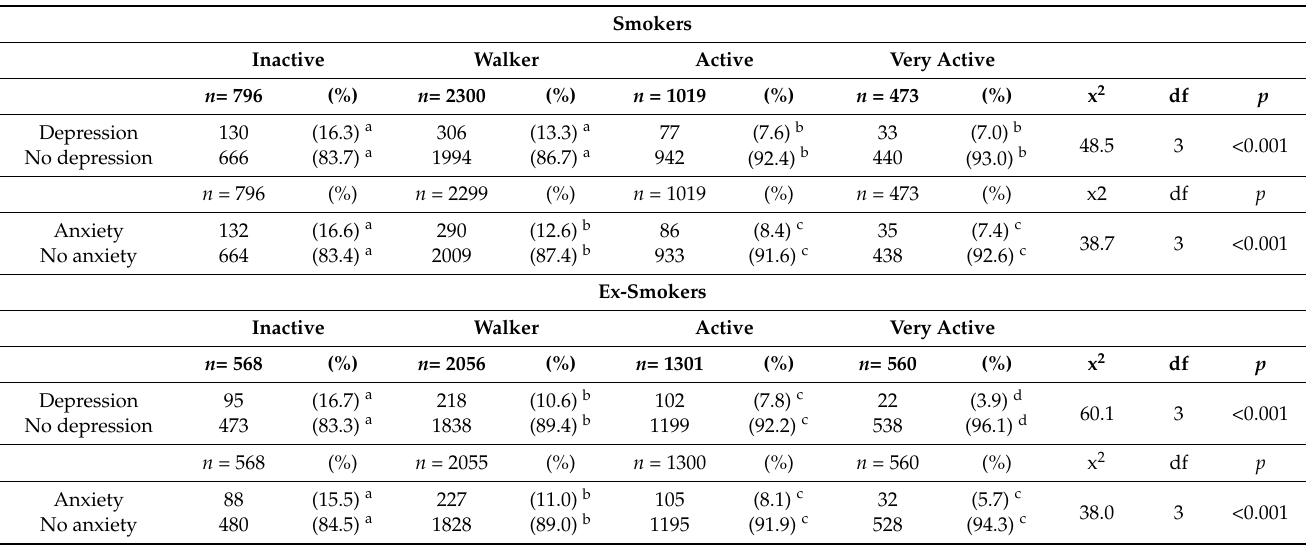
Table A6. Prevalence of depression and anxiety in Spanish smokers and ex-smokers according to physical activity level: ENSE2017.